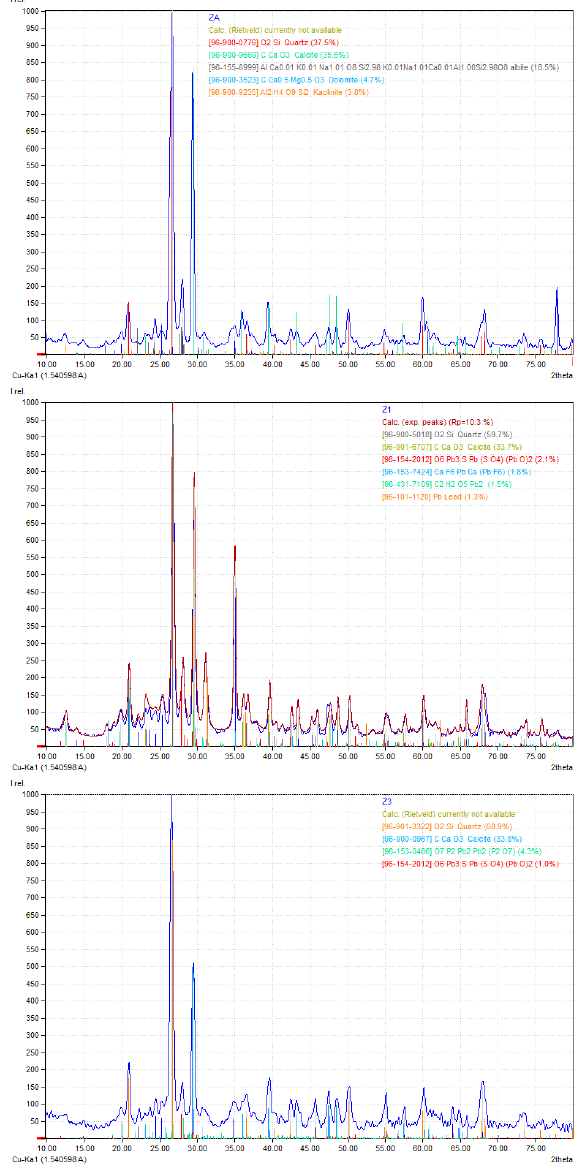
Figure 7: XRD of soil (a) soil before treatment (b) lead polluted soil with Cementation reagent (c) lead polluted soil with the bacterial solution and Cementation